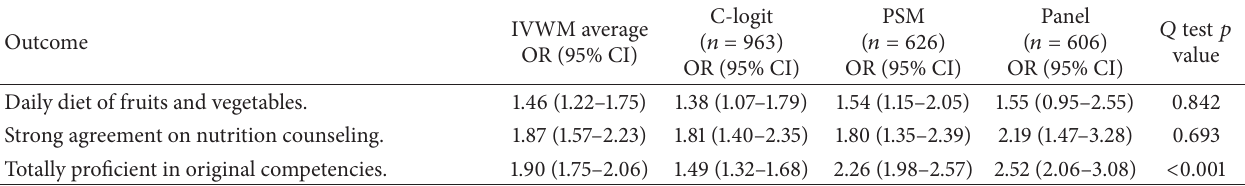
C-logit PSM Panel 𝑄 test 𝑝 IVWM average ( 𝑛 = 963 ) ( 𝑛 = 626 ) ( 𝑛 = 606 ) OR (95% CI) value OR (95% CI) OR (95% CI) OR (95% CI)